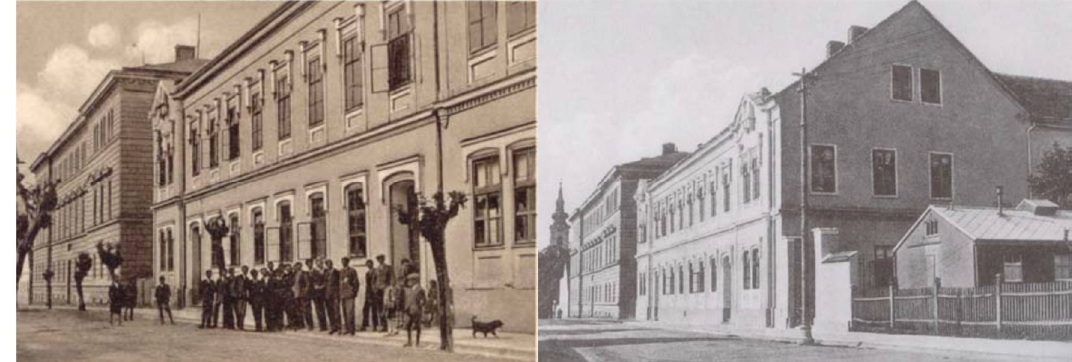
Figure 6. The building of the First Primary School in Petrinja in the 1930s [46].